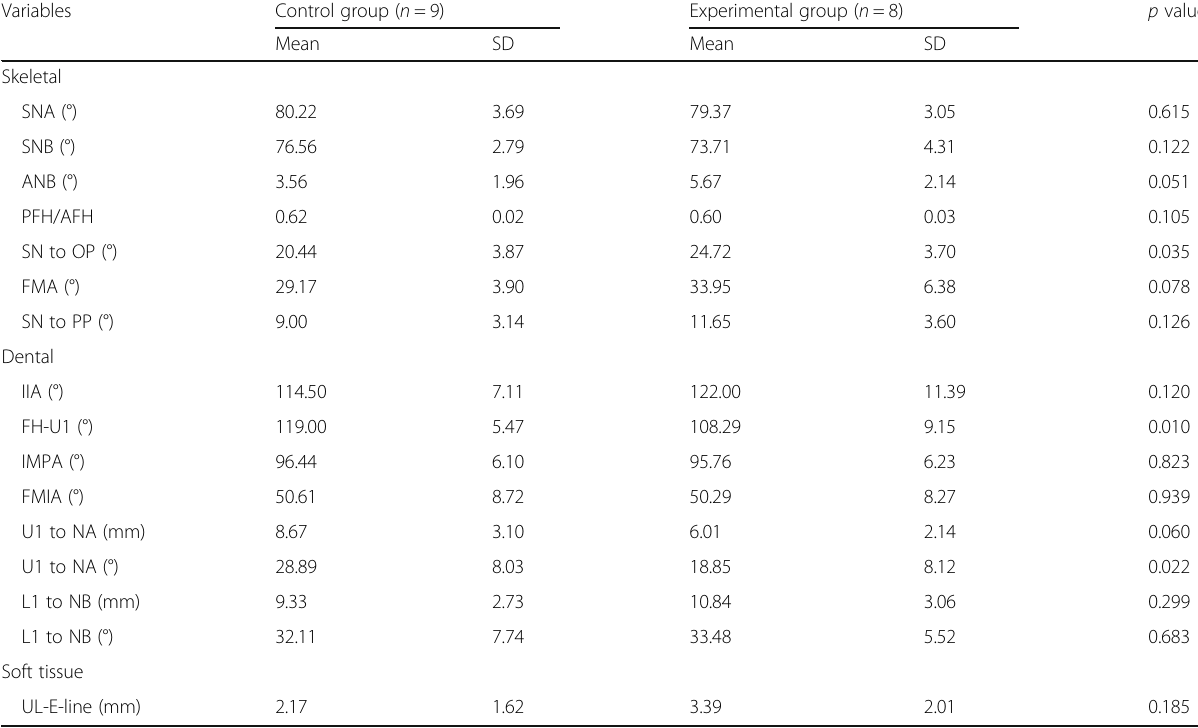
Table 1 Cephalometric variables of the samples before treatment Variables Control group ( n = 9) Experimental group ( n =